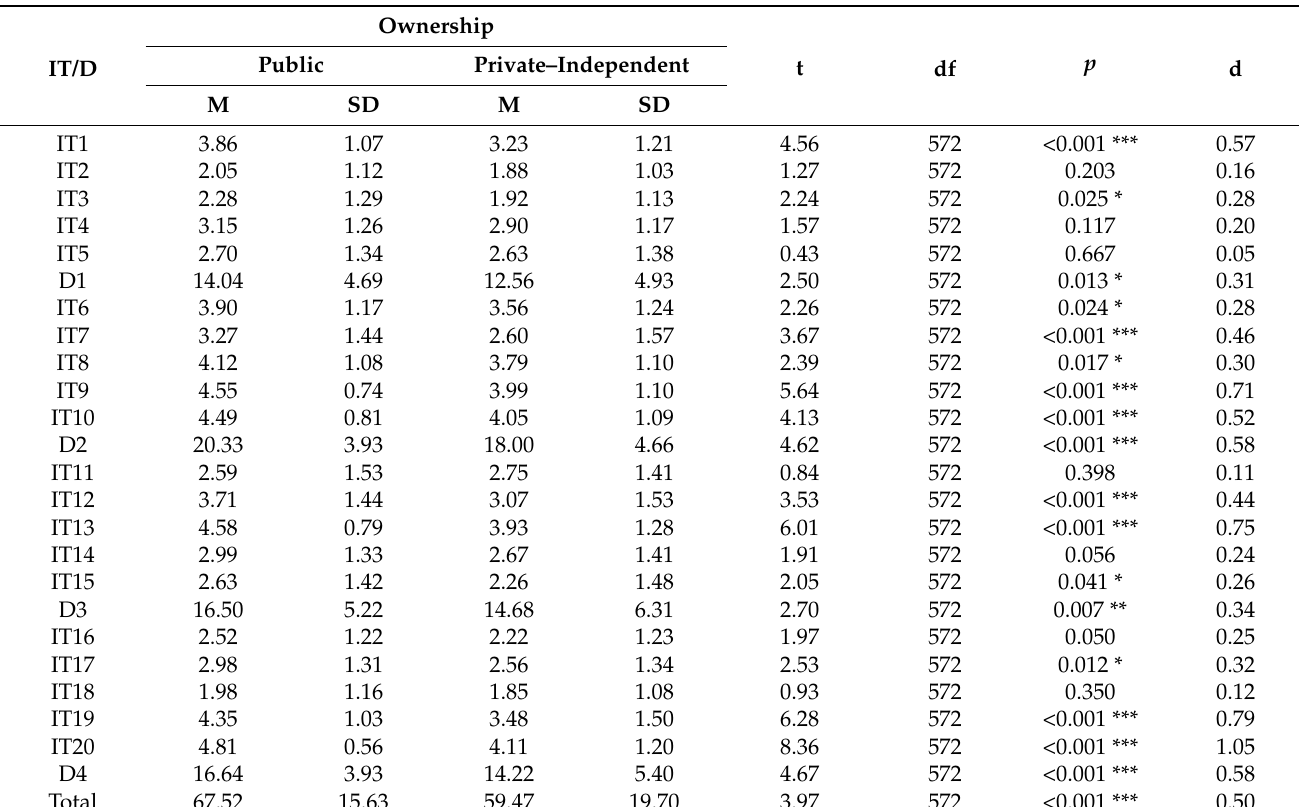
Table 4. T -test based on the variable school type.